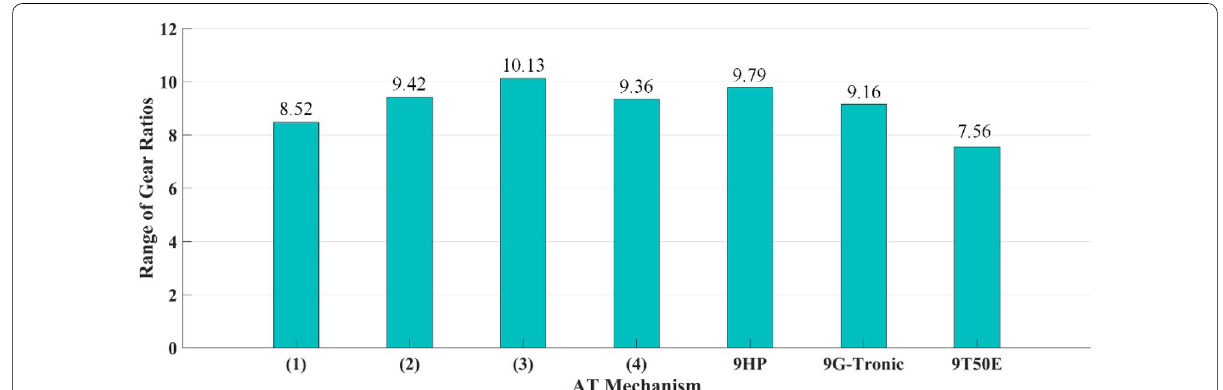
Figure 18 Comparative analysis of the ranges of gear ratios of the seven AT mechanisms